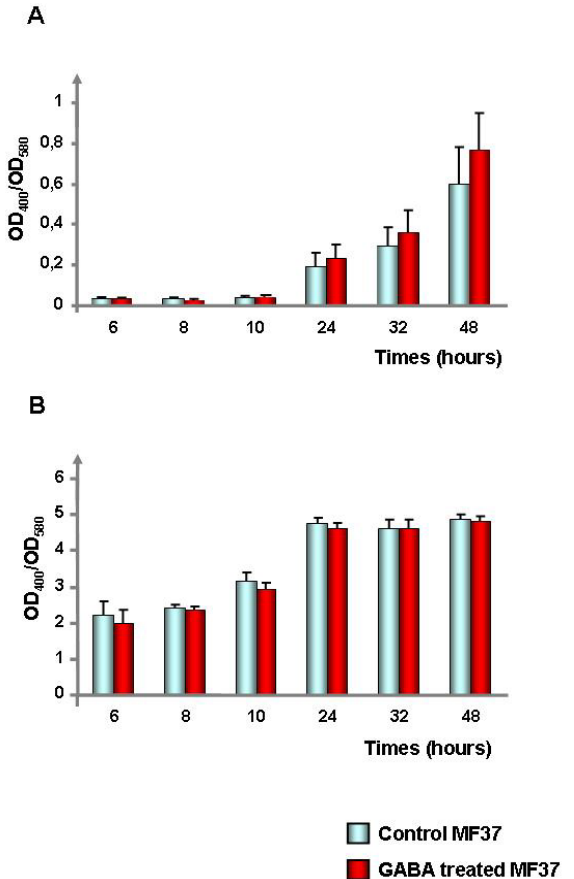
Figure 6. Effect of GABA (10 − 5 M) on pyoverdine production by P. fluorescens MF37. The pyoverdine production was measured in King B ( A ) and Bacto Casamino Acids (CAA) ( B ) medium. The production of pyoverdine is expressed as the ratio of pyoverdine ) on the OD nm of the bacterial adsorption (OD 400 580